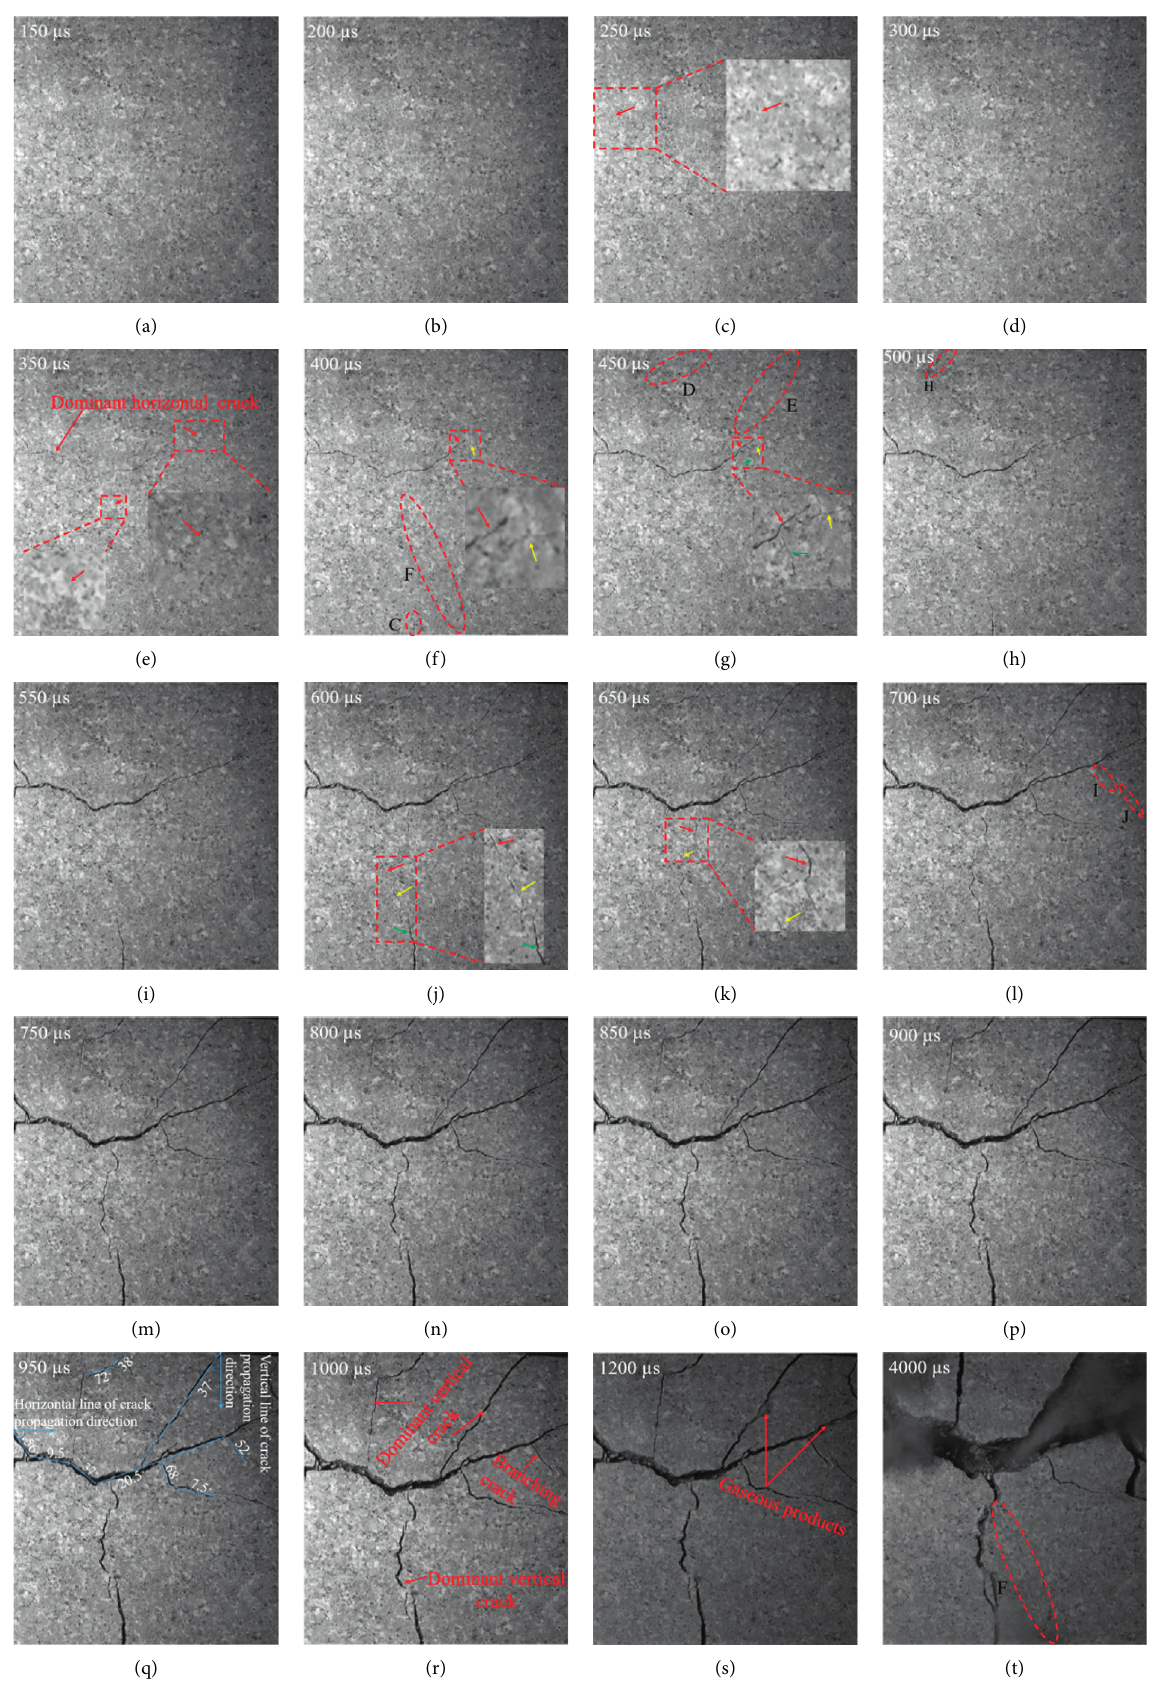
Figure 9: The crack evolution for test 2 (the magnification of the enlarged part is 300%). (a) 150 μ s. (b) 200 μ s. (c) 250 μ s. (d) 300 μ s.